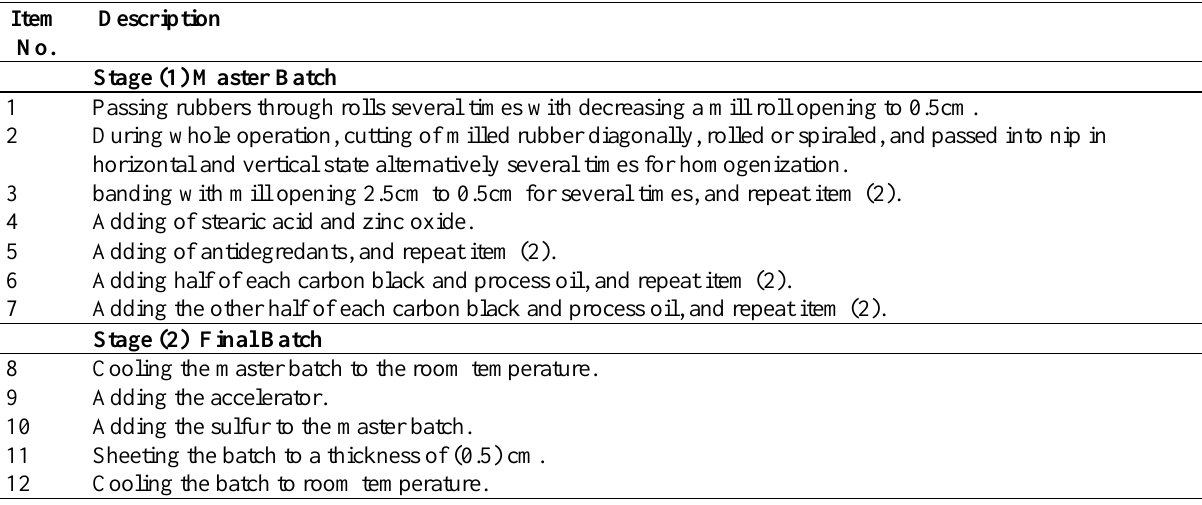
Schedule of Mixing Cycles[13].